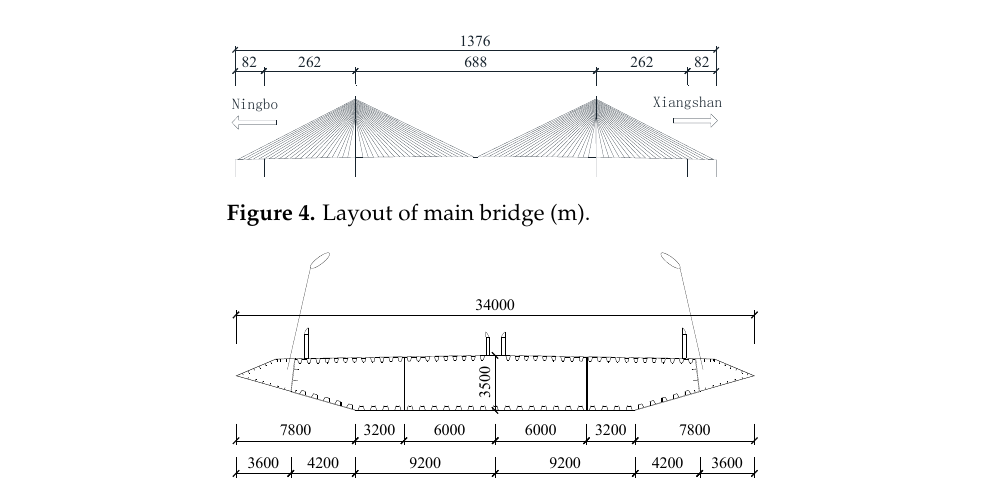
Table 1. Modal analysis results of Xiangshan Harbor Bridge.